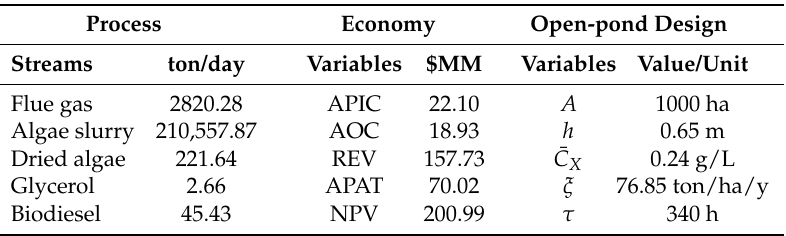
Table 7. Summary of optimization results from Optimization Strategy I. Economic variables include annual project investment cost (APIC), annual operating cost (AOC), revenue (REV), annual actual profit after tax (APAT), and net present value